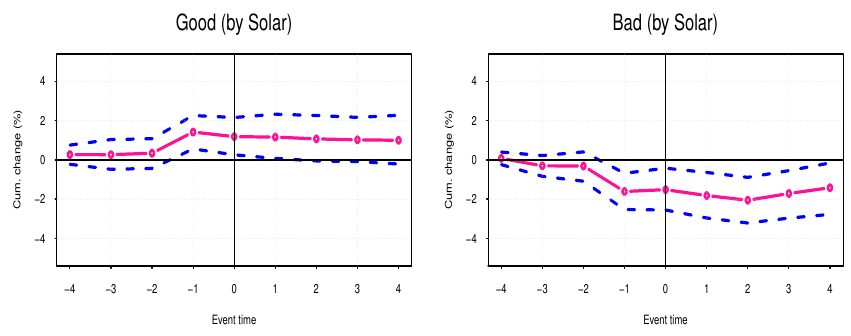
Figure 8. Extreme event on Solar and response of WTI